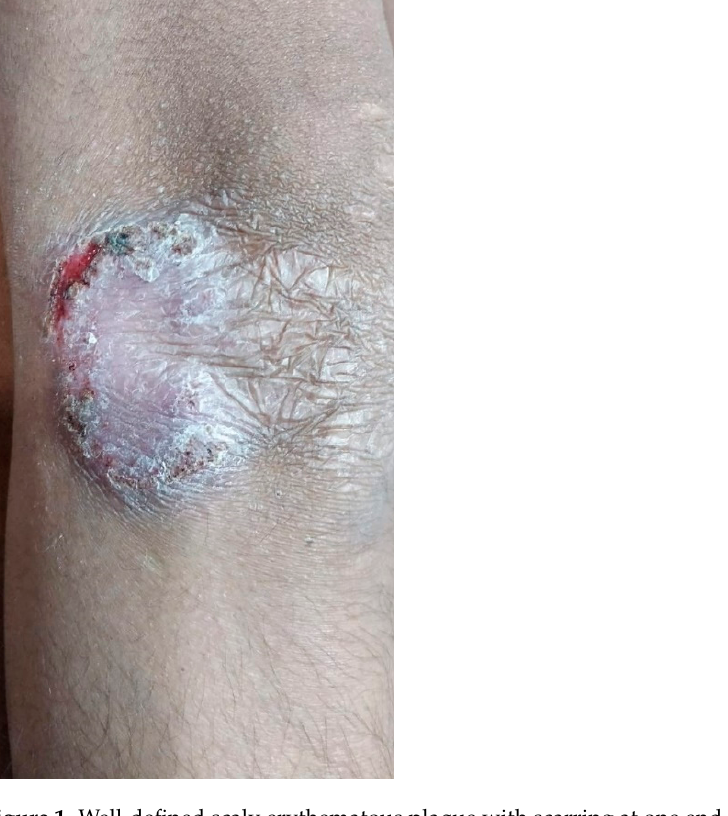
Figure 1. Well-defined scaly erythematous plaque with scarring at one end located on elbow.